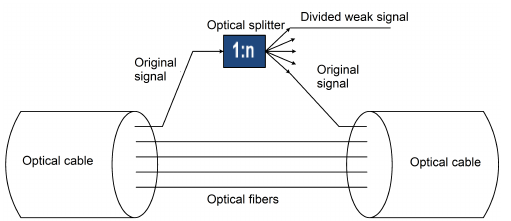
Figure 1. Data leakage by inserting a splitter into the ODN.